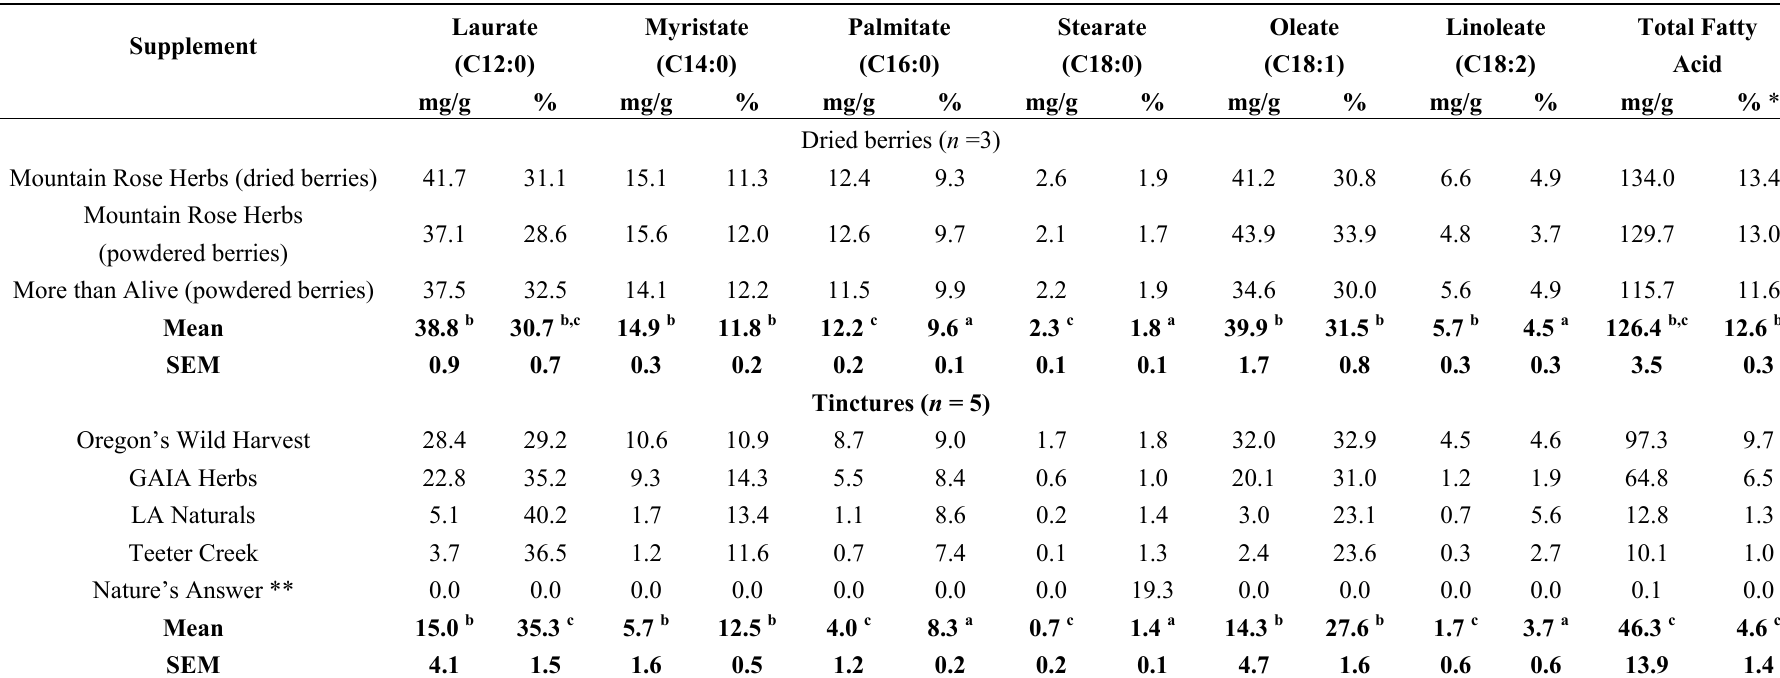
Table 3. Fatty acid quantities (mg/g) and composition (% of total fatty acids) in dried berry and tincture saw palmetto supplements.